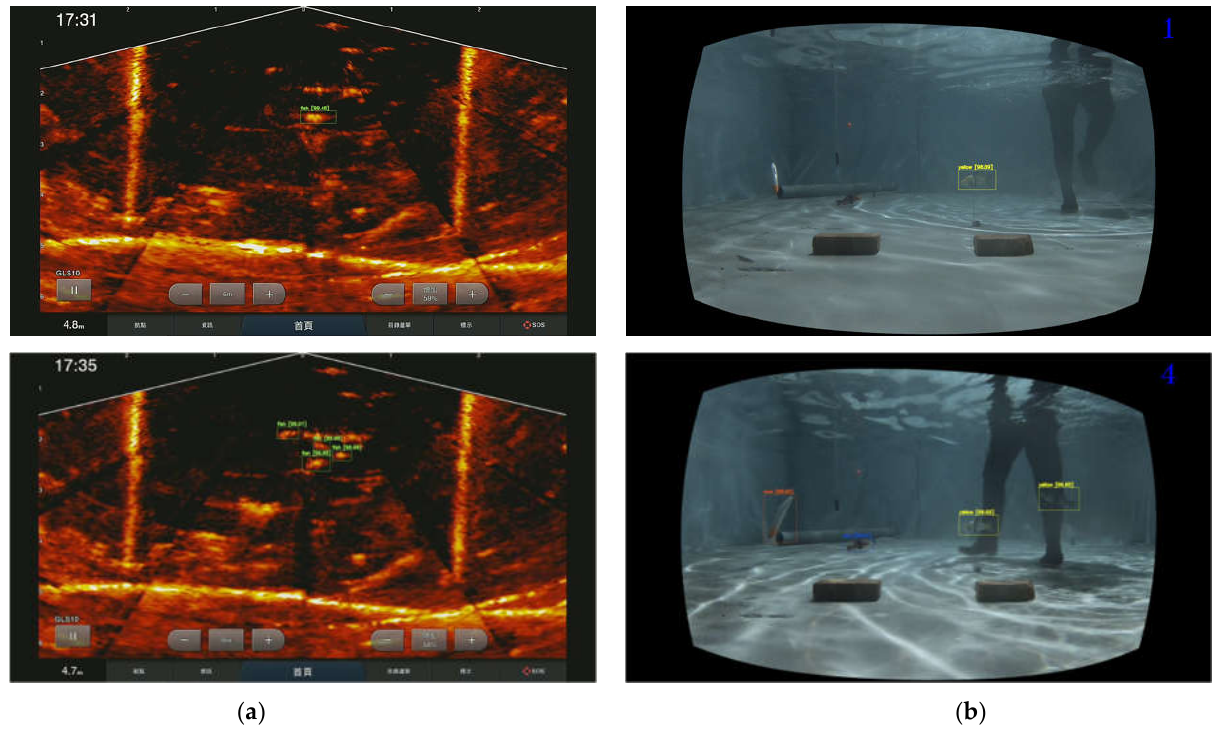
Figure 19. Fish classification results using ( a ) sonar and ( b ) stereo images.